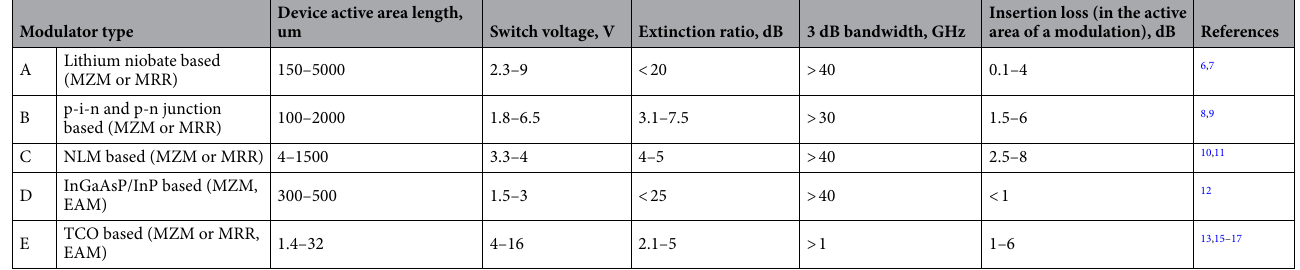
Table 1. Comparison of electro-optical modulators